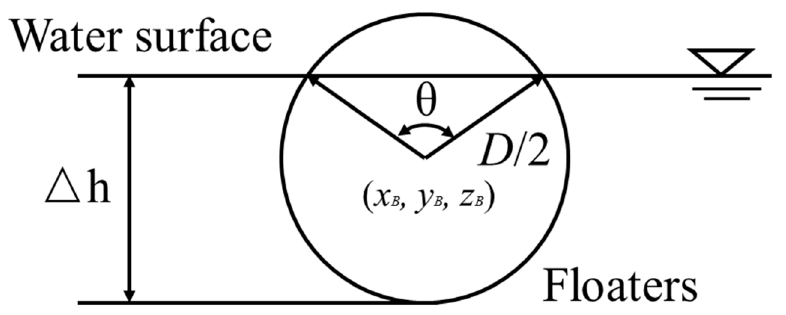
Figure 2. Sketch of the floater.